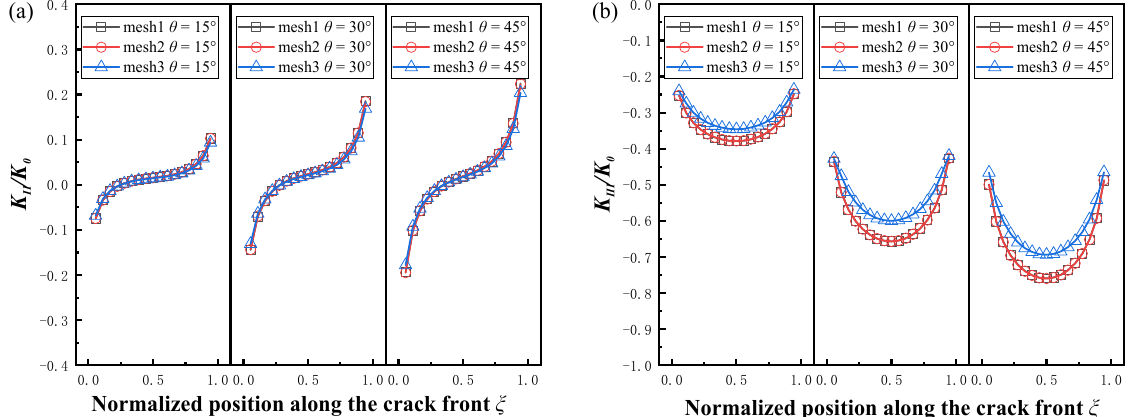
Table 1. Crack front meshing.